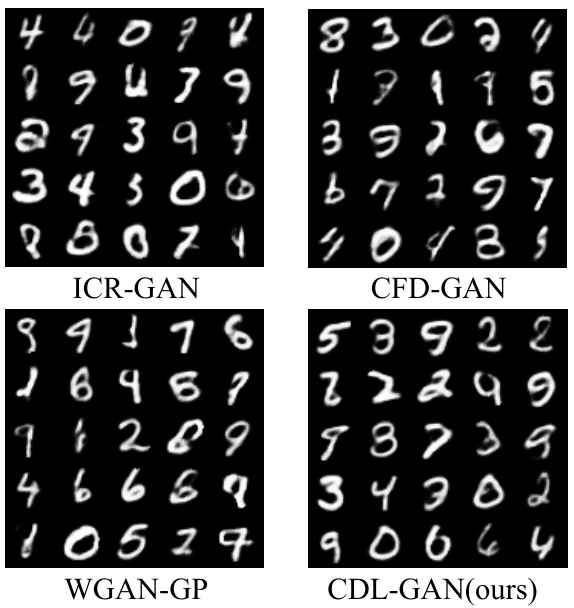
Figure 5. Image samples from different models on MNIST dataset.